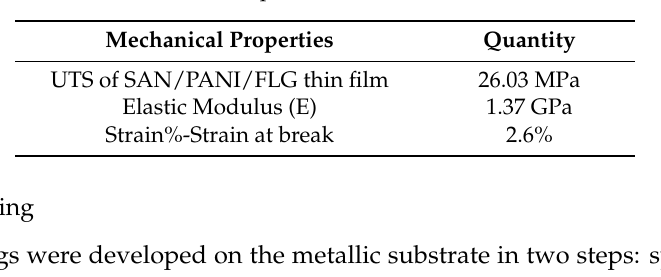
Table 3. Mechanical Properties of SAN/PANI/FLG thin film.